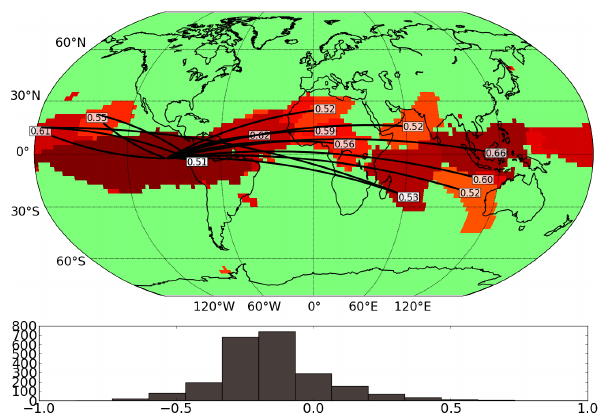
Fig. 16. Pairs of regions that show high relevance for the global graph evolution, when the inter-regional graph threshold at each time point is set equal to the global 2562-node grid graph with den- sity 0.005. Visualisation as in Fig.